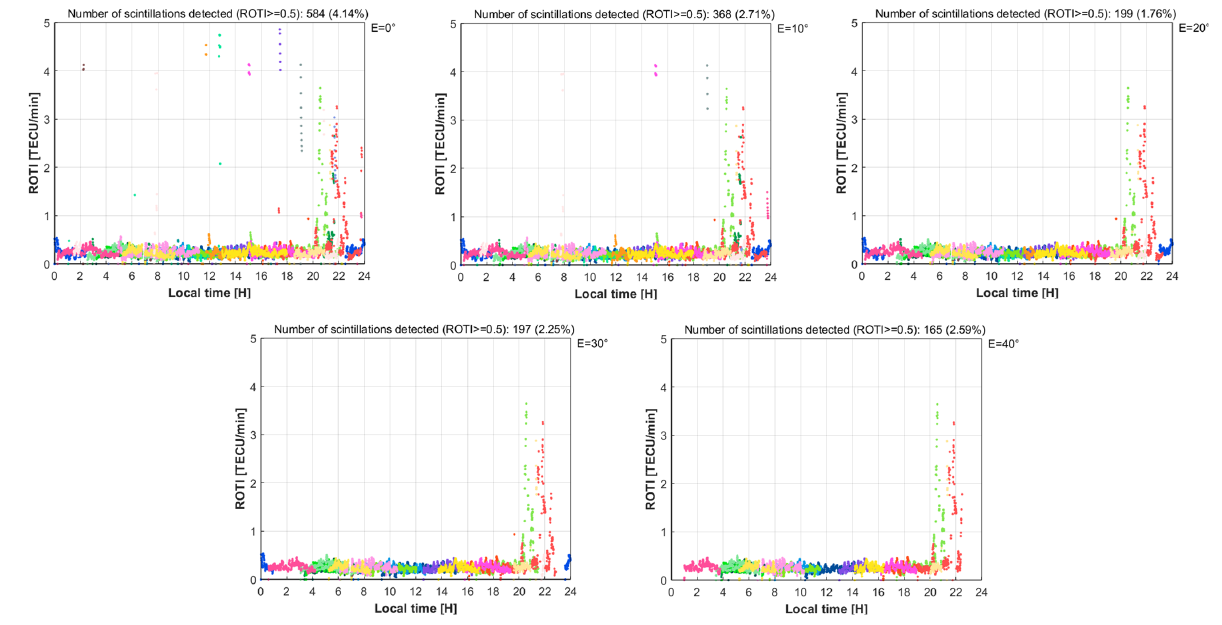
Figure 6. Comparison of scintillation events with different elevation thresholds at Hanoi station (Vietnam) on 24 October 2015. It can be seen that the different threshold elevations give very different amounts of detectable irregularities, with the threshold elevation of 20° eliminating most of the multipath noise while keeping essentially the required number of observations. Table 1. Comparison of scintillation events with different elevation thresholds (time span calculation is five minutes).